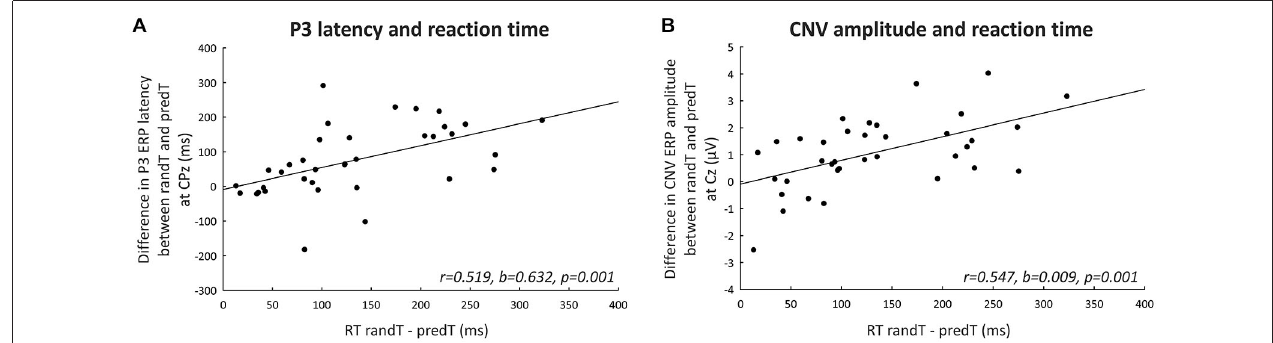
FIGURE 7 | Correlations with a behavioral measure of prediction. (A) Difference in maximum P3 ERP latency (ms) between randTs and predTs at CPz plotted against the difference in reaction time between randTs and predTs (ms). (B) Difference in CNV ERP amplitude (microvolts) between randTs and predTs at Cz plotted against the difference in reaction time between randTs and predTs (ms). The solid lines represent the linear